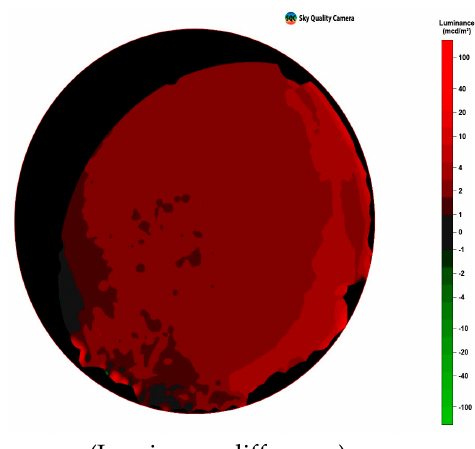
Figure 6. The upper row shows the all-sky RGB images at Padova, Italy, for a clear sky on 4 February 2019 at 20:00 local time and 5 February 2019 at 03:30 local time. The middle row shows luminance maps for the same time. The lower row shows the difference between luminance obtained from subtracting images. The orange arrow indicates Sant’Antonio ’s church.